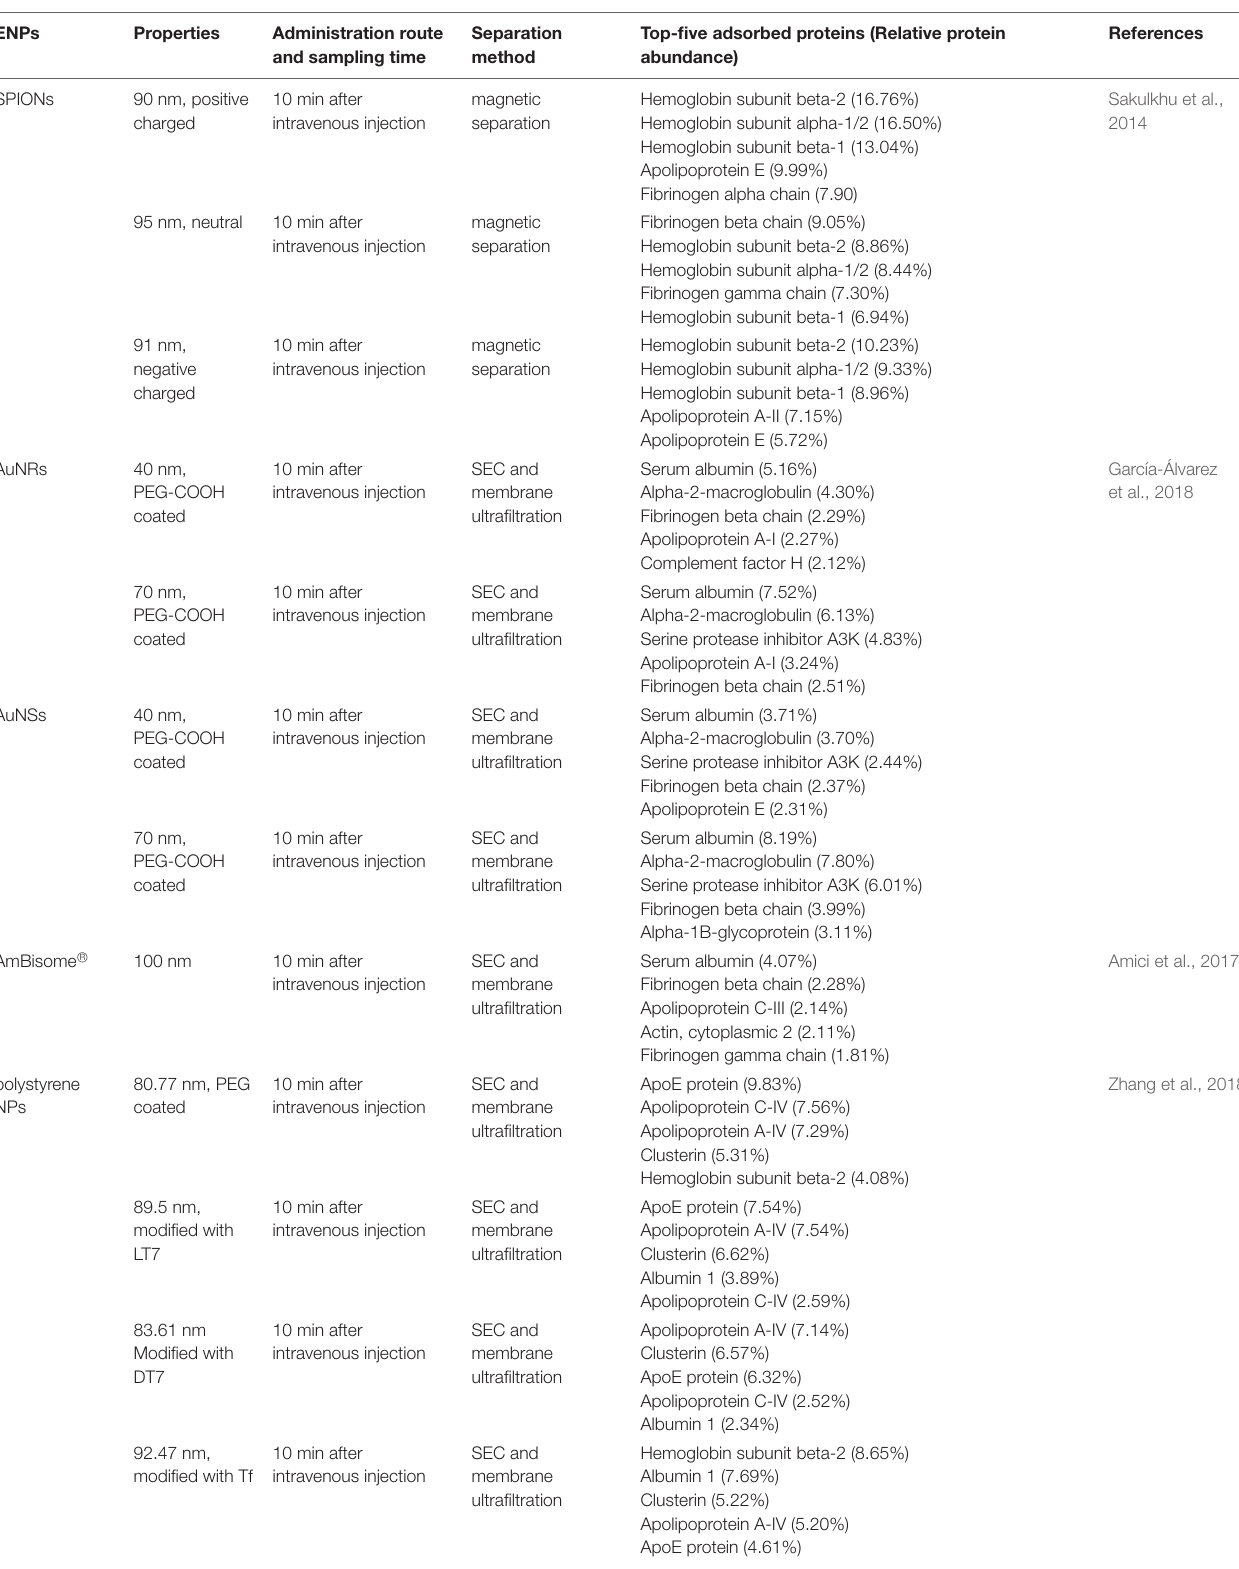
TABLE 1 | Top-five adsorbed proteins of some ENPs with different properties and the separation methods. ENPs